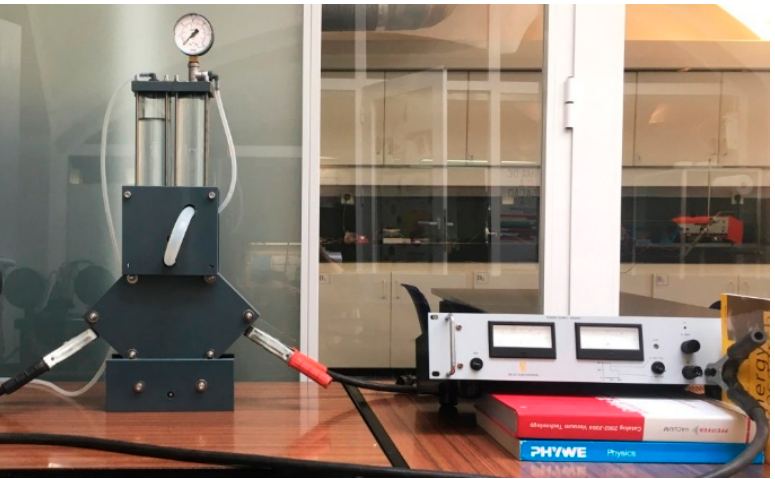
Figure 3. Prototype dry cell with power source.